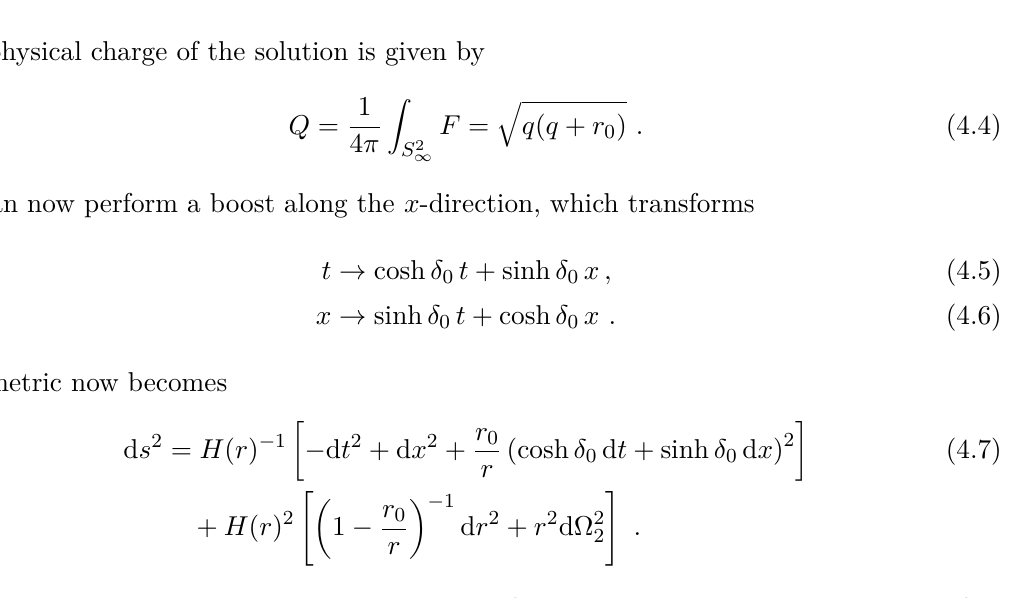
Figure 4 . Sketch of the five-dimensional black string geometry. The coordinate x is periodic, shown with identifications on the left, while on the right t is suppressed. In the coordinates of (4.7) the ring singularity is at r = − q and the two horizons (red), located at r = 0 and r = r 0 , have topology S 1 × S 2 at fixed t . The four-dimensional black hole is found by reducing over x (leading to a horizon of spacial topology S 2 and a point-like singularity). The BTZ × S 2 geometry is found in the near-horizon